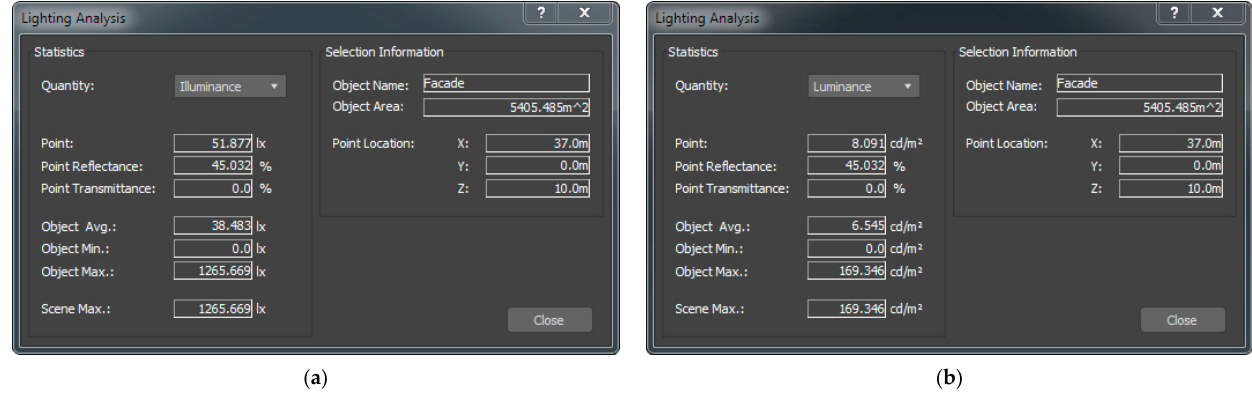
Figure 10. A measuring window for the lighting analysis function for ( a ) illuminance, ( b ) luminance in the floodlighting design made on the 3D model optimised towards the photometric calculations.